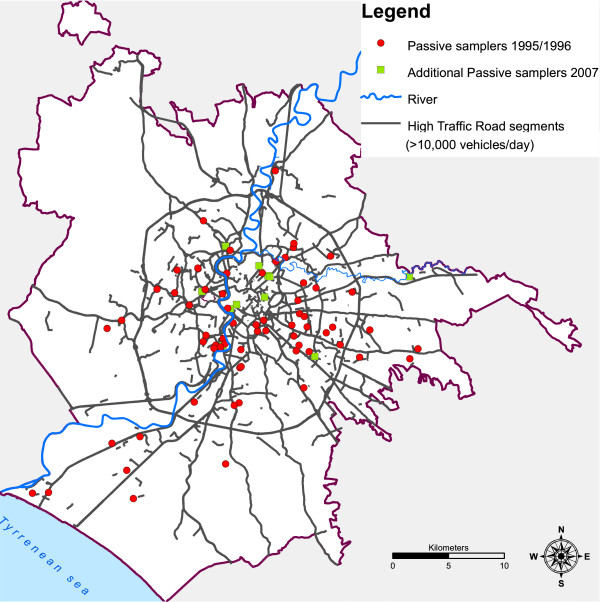
Location of NO2measurements, and high traffic roads (>10,000 vehicles/day), Rome.